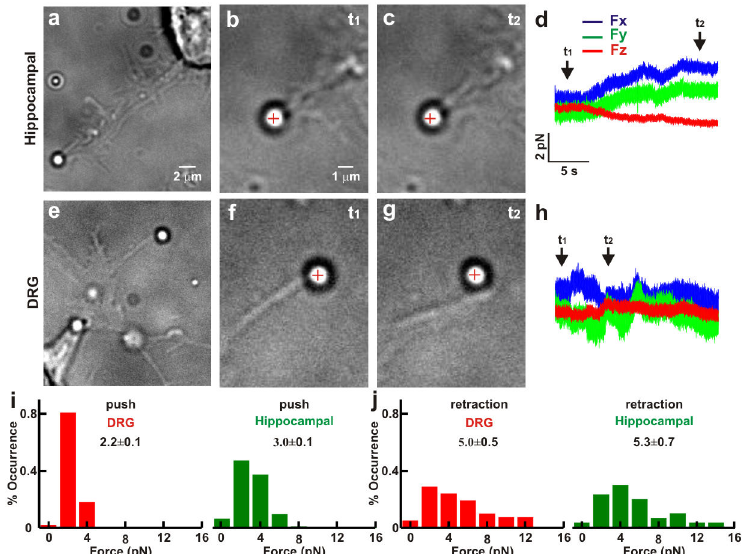
Figure 2. Comparison of the force exerted by filopodia from hippocampal and DRG GCs. ( a ) Low resolution image of a bead trapped in front of a filopodium emerging from a GC of hippocampal neuron. ( b – c ) High resolution images during a push by a filopodium. At t the bead is in the optical trap ( b ) and at t the filopodium pushes the bead ( c ). The cross indicates the center of the 1 2 optical trap. ( d ) The three components F , F , and F of the force exerted by the filopodium. ( e – h ) As in ( a – d ) for a filopodium x y z emerging from a GC of DRG neuron. ( i ) Histogram of the force measured during a push in DRG (n=58) and hippocampal (n=64) neurons. ( j ) As in ( i ) but during retraction (n=31 and n=23 respectively). The trap stiffness is k =0.10, k =0.03 pN/nm. All values x,y z reported in i-j are given as mean ±